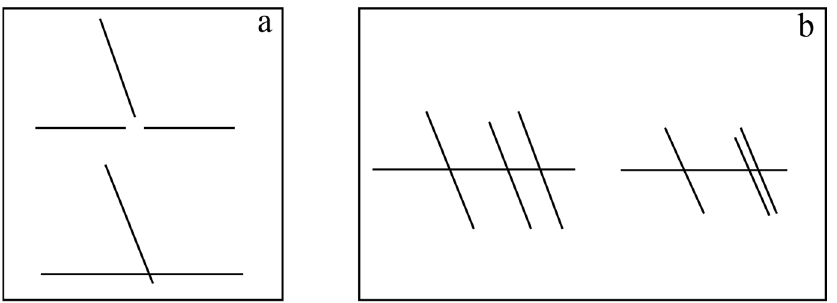
Figure 1. Different types of topology conflict: ( a ) topology conflict of type I and ( b ) topology conflict of type II.